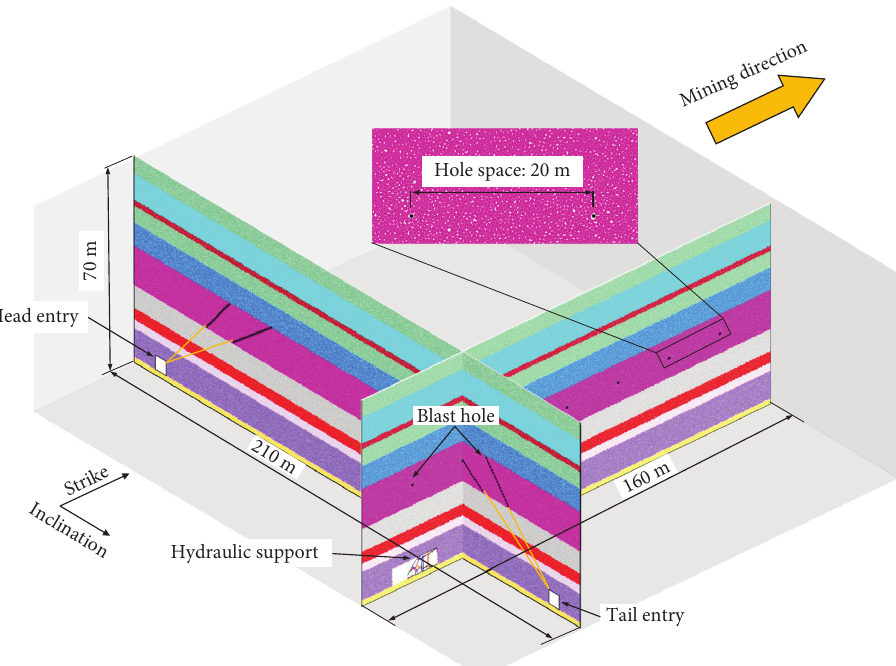
Figure 4: Diagram of strike and dip models and blasting